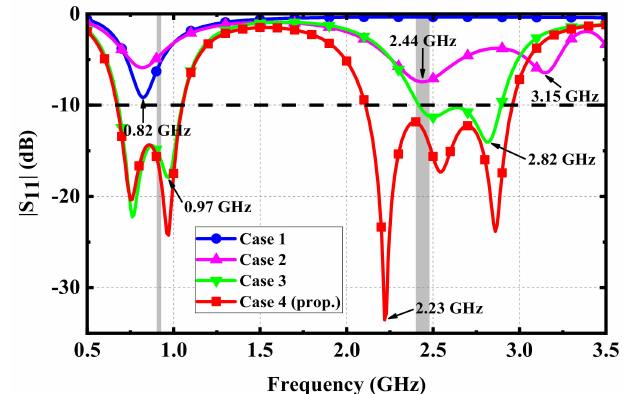
Figure 4. Simulated results of different cases.